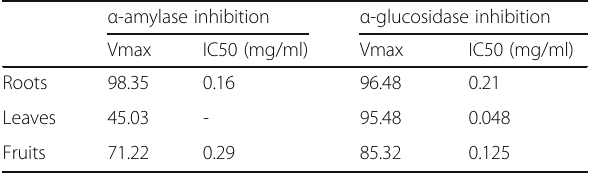
Table 1 Vmax and IC50 values of various organs of S. spinosum against α -amylase and α -glucosidase activity α -amylase inhibition α -glucosidase inhibition Vmax IC50 (mg/ml) Vmax IC50 (mg/ml)